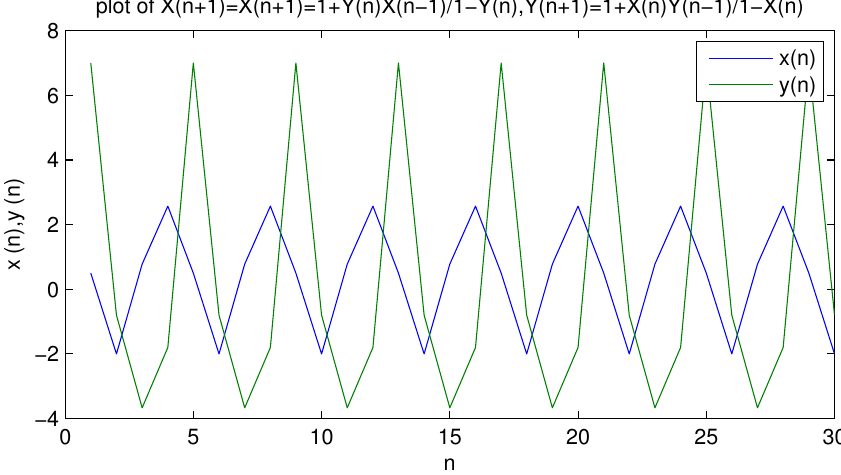
Figure 1. Represents behavior of System (1) when x − 1 = 0.5, x 0 = − 2, y − 1 = 7 and y 0 = −